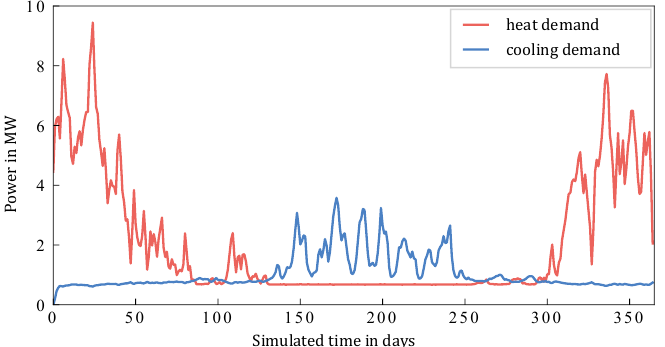
Figure 14. Aggregated heat and cooling demands (daily